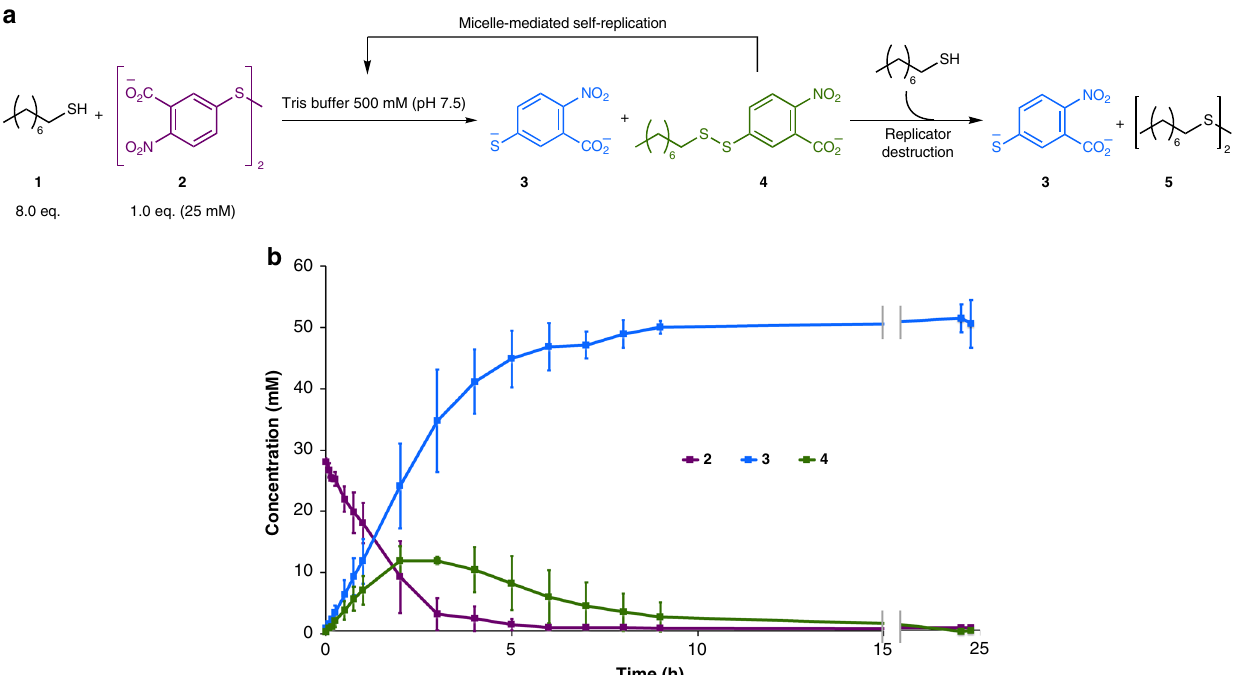
Fig. 4 Closed system behaviour: the destruction of the replicator. a Thiol-disul fi de exchange between neat octanethiol 1 and aqueous disul fi de 2 produces a mixed disul fi de surfactant 4 and anionic by-product 3 . Micelles of surfactant 4 increase mixing between the phase-separated reactants and catalyse the reaction to form their own components. However, 4 is subject to a destruction reaction to form thermodynamic products 3 and 5 . b Concentration of all UV active species 2 , 3 , and 4 over the full course of reaction. Surfactant 4 is unstable towards attack by additional 1 to give waste products 3 and 5 and the equilibrium position of the system is for complete degradation of 4 . The concentration of reaction components was monitored by UPLC. Each plotted point is the average of three reactions and the error bars represent the standard